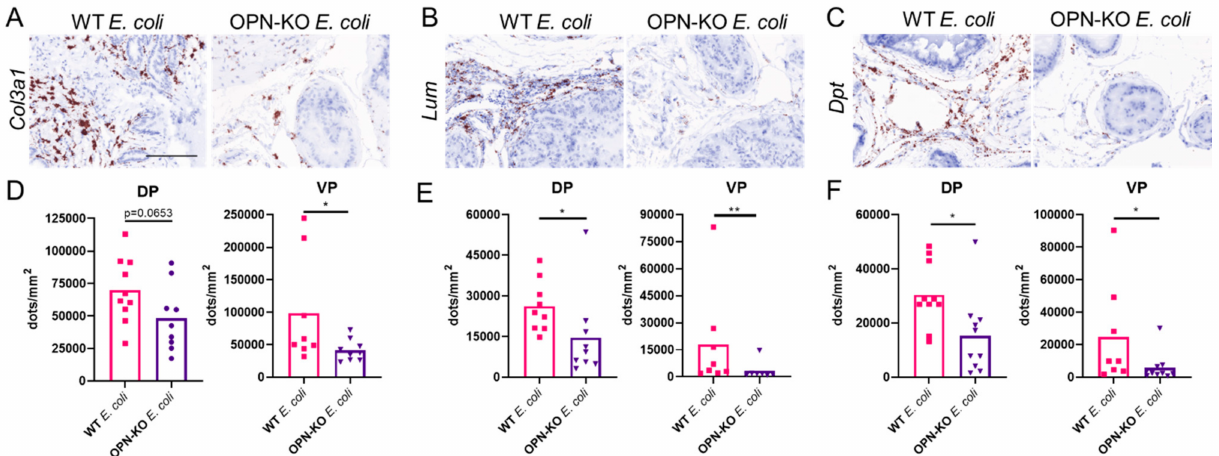
Figure 8. The pro-fibrotic genes, Col3a1 , Lum and Dpt , are suppressed by osteopontin (OPN) deficiency. Panels ( A – C ) are representative images, and ( D – F ) show quantification of RNAscope staining of Col3a1 , Lum and Dpt , respectively, in the dorsal (DP) and the ventral prostate (VP) from E. coli -instilled wild type (WT) and osteopontin knockout (OPN-KO) mice. Significance was tested using Mann–Whitney test. Images were captured at 40 × magnification. Scale represents 100 µ m. * p < 0.05; ** p <